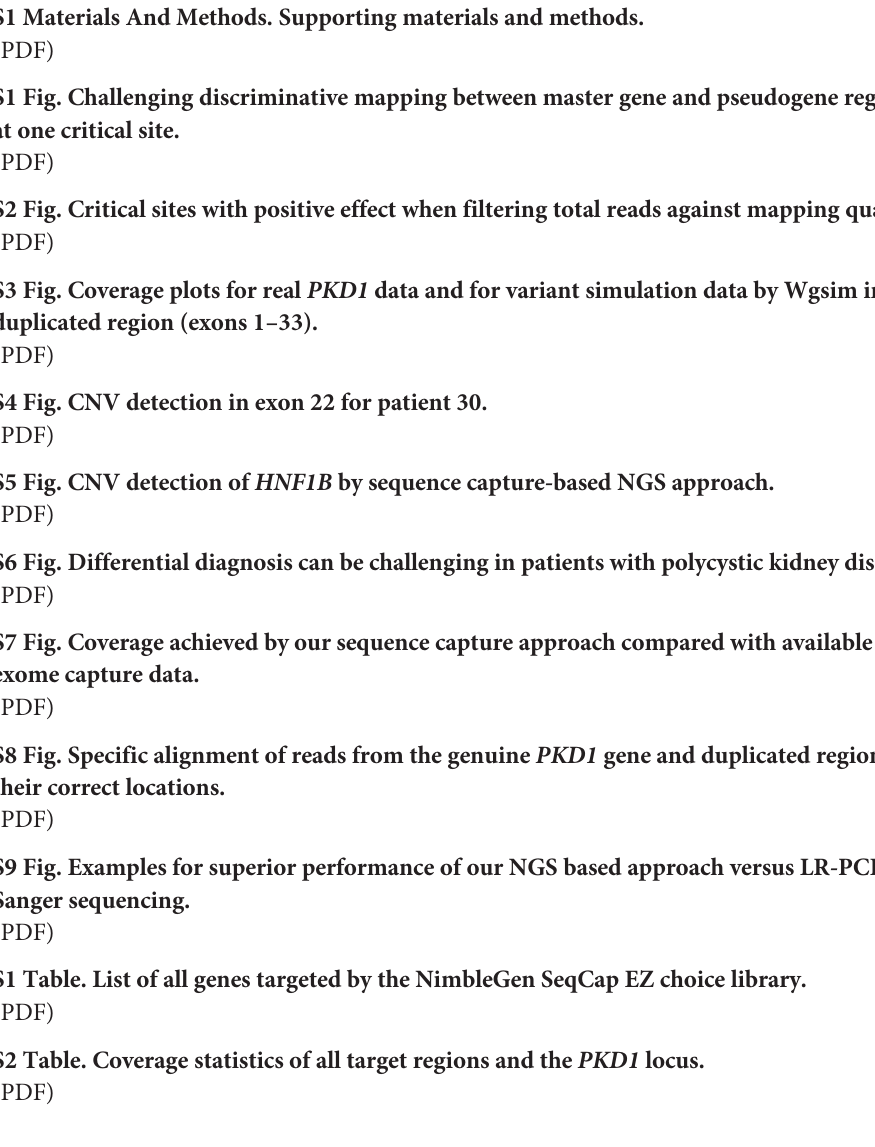
S1 Fig. Challenging discriminative mapping between master gene and pseudogene regions at one critical site.